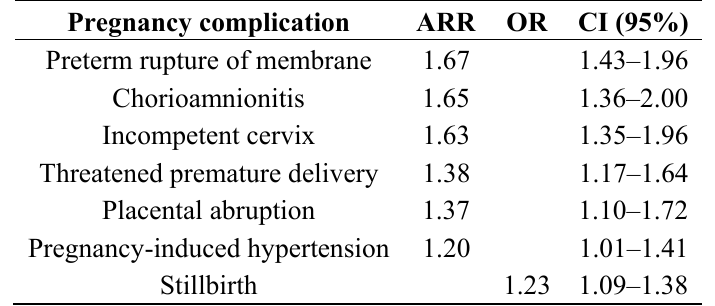
Table 1. Pregnancy complications due to smoking; modified after